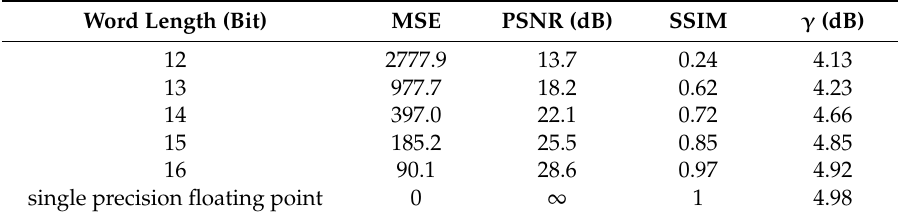
Actual scene (overall region) imaging quality assessment for different FFT processing accuracies.